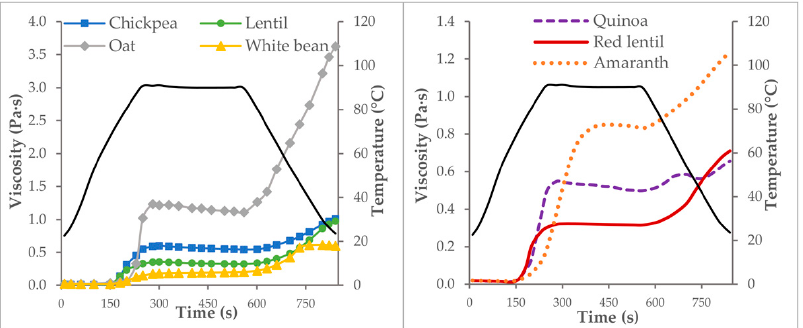
Figure 2. Viscosity curves of flour/water mixtures (10%) as a function of temperature (black line) and time.